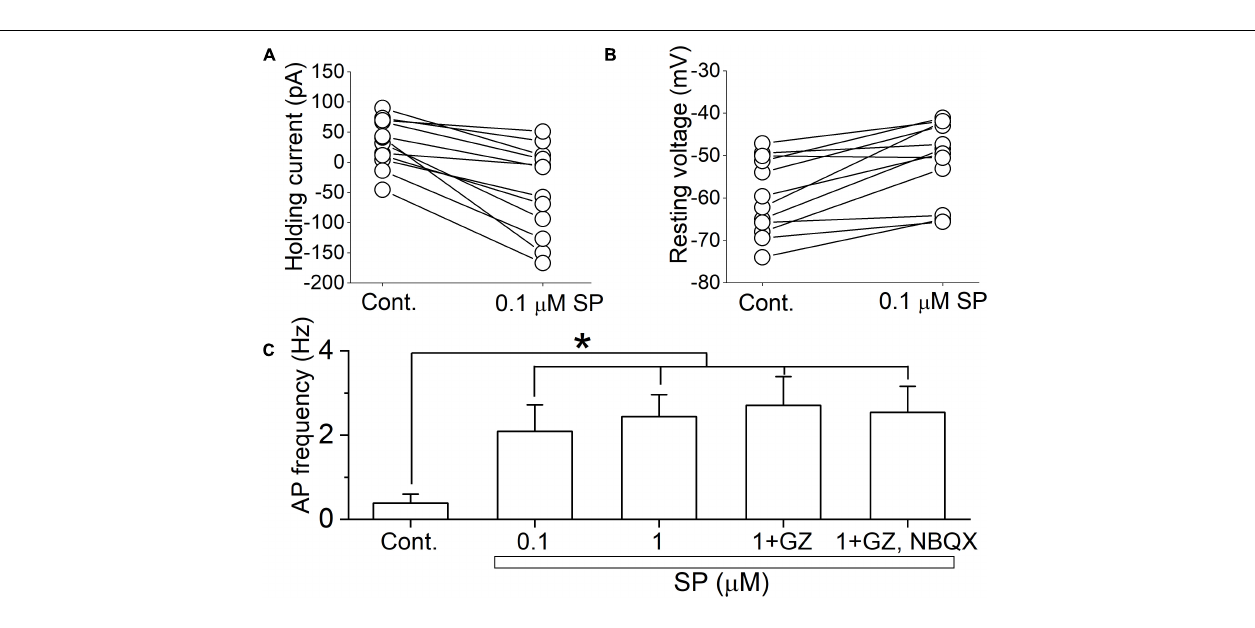
FIGURE 10 | SP-induced depolarization is a major contributor to action potential firing. (A) The holding current was recorded before and during a 5 min application of 0.1 µ M SP at a holding potential of -50 mV ( n = 12). (B) The resting membrane potential was recorded from the same set of neurons as in (A) in current clamp mode without current injection. Connected points represent measurements from individual cells before and after application of 0.1 µ M SP. (C) The action potential frequency was calculated under the control conditions and after application of 0.1 and 1 µ M SP, 1 µ M SP + gabazine, and 1 µ M SP + gabazine + NBQX (20 µ M) ( n = 12). All columns and error bars indicate the mean ± SDM, * P < 0.05 vs.